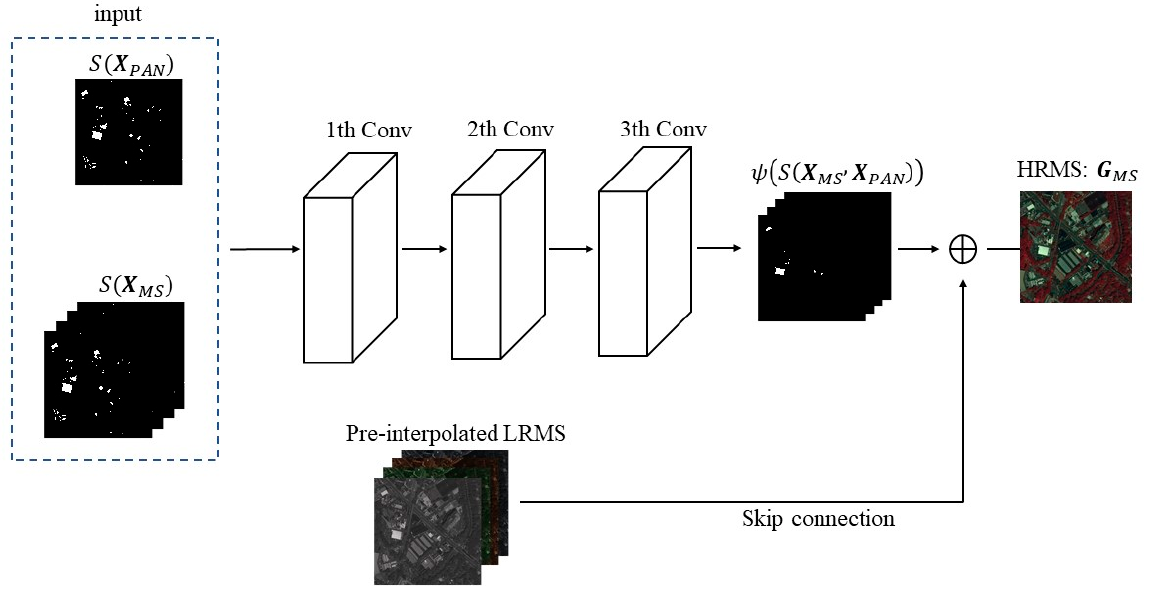
Figure 4. Flowchart of our network structure.